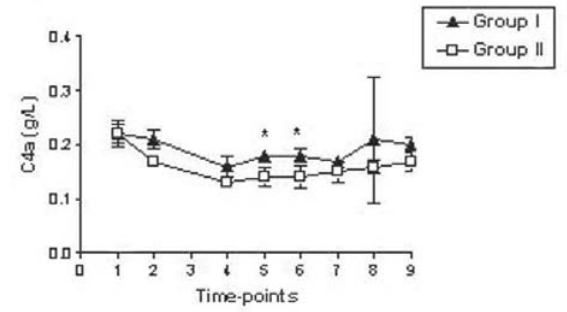
Fig. 2 - C4a values over time. Group 1 - no ultrafiltration; Group